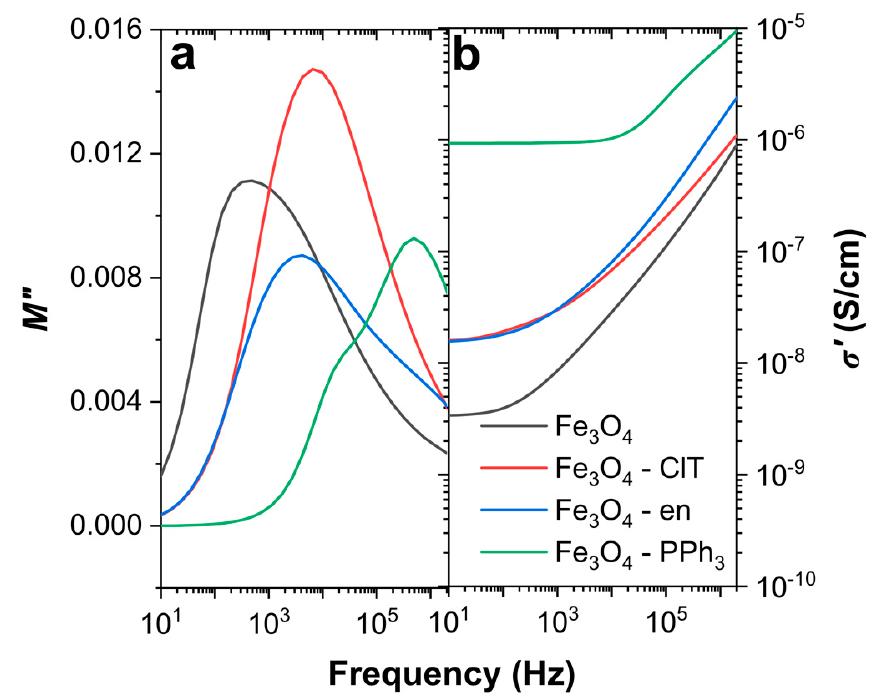
Figure 6. Comparison of electric properties of magnetite nanoparticles at a constant temperature equal to 173 K: ( a ) imaginary part of the dielectric modulus; and ( b ) real part of the electrical conductivity.